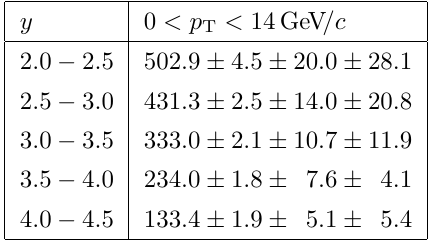
Table 7 . Single-differential production cross-sections d σ [nb per unit rapidity] for nonprompt J/ψ d y mesons. The first uncertainties are statistical, the second are correlated systematic uncertainties shared between intervals, and the last are uncorrelated systematic uncertainties.